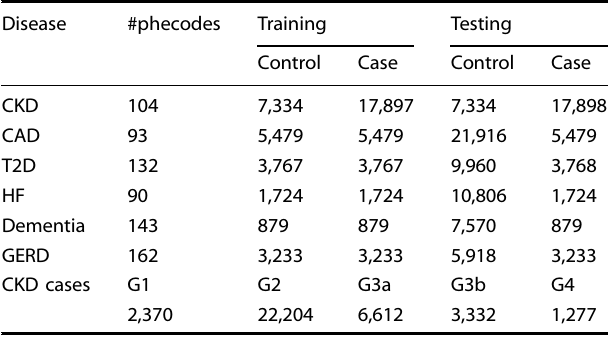
Table 1. Number of individuals (cases vs. controls) in training and test